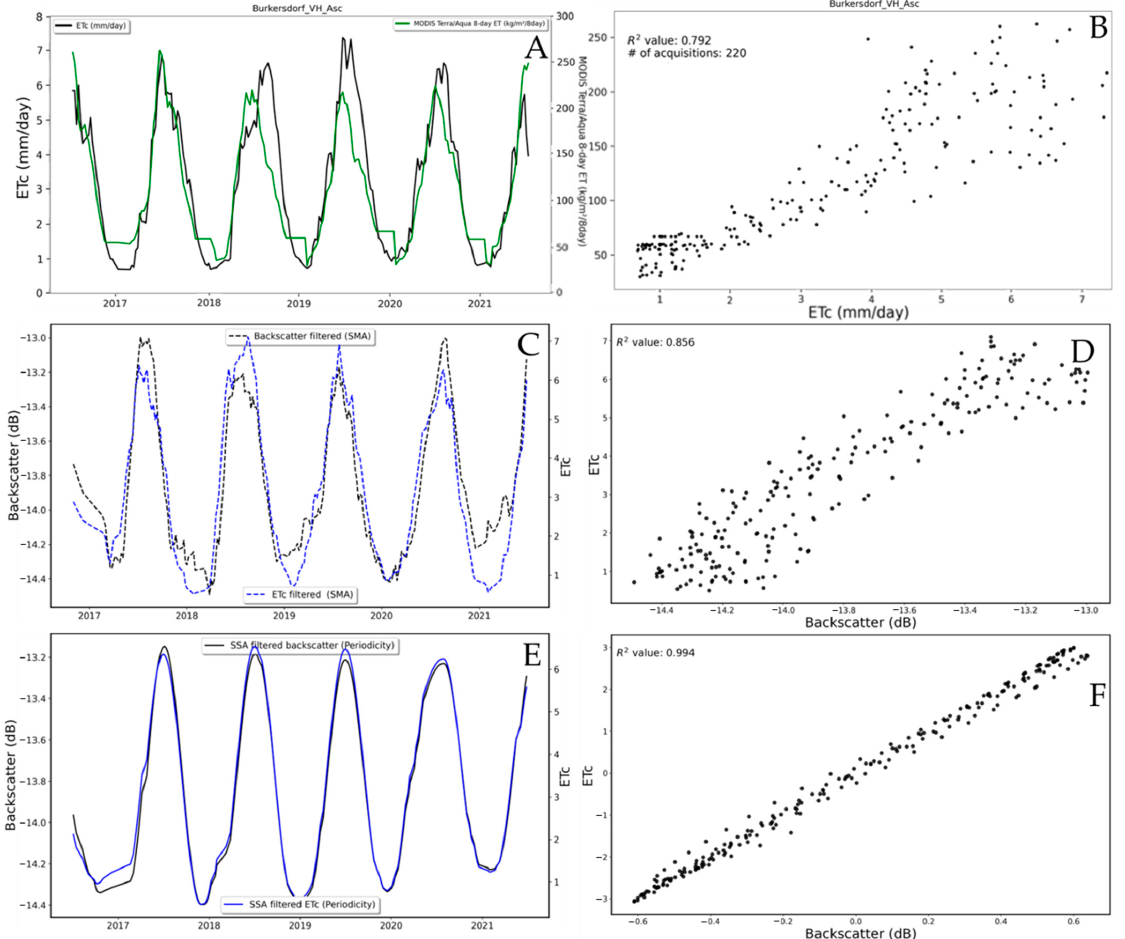
Figure 7. A very similar seasonal behavior for the Terra/Aqua MODIS (green) and in situ (black) ET product ( A ), the correlation between both ET products ( B ), SMA-filtered Sentinel-1 time series ( C ) SSA-filtered Sentinel-1 time series ( E ) can be seen. The correlation scatter plot of SSA- and SMA- filtered ( D , F ) Sentinel-1 time series and ET products show a positive trend, meaning increasing backscatter values also mean increasing evapotranspiration values. All data were acquired for station “Burkersdorf” and cross-polarized (VH) Sentinel-1 backscatter in ascending pass direction. A noticeable decrease in correlation for the ascending overpass direction can be ob- served at the AOI “Oberweissbach”, where the correlation values are systematically lower compared to the other stations. At the same time, the correlation for the descending over- pass direction is on a similar level compared to the other AOIs. This might be explained by the relatively steep slope angles of the AOI “Oberweissbach”, making this area more prone to influence by the local incidence angle compared to the other AOIs. Additionally,